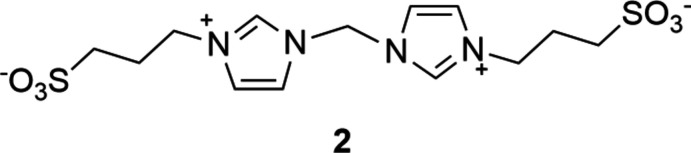
Structural formula of 3,3′-[1,1′-methyl­enebis(1H-imidazole-3-ium-3,1-di­yl)]bis­(propane-1-sulfonate (2).